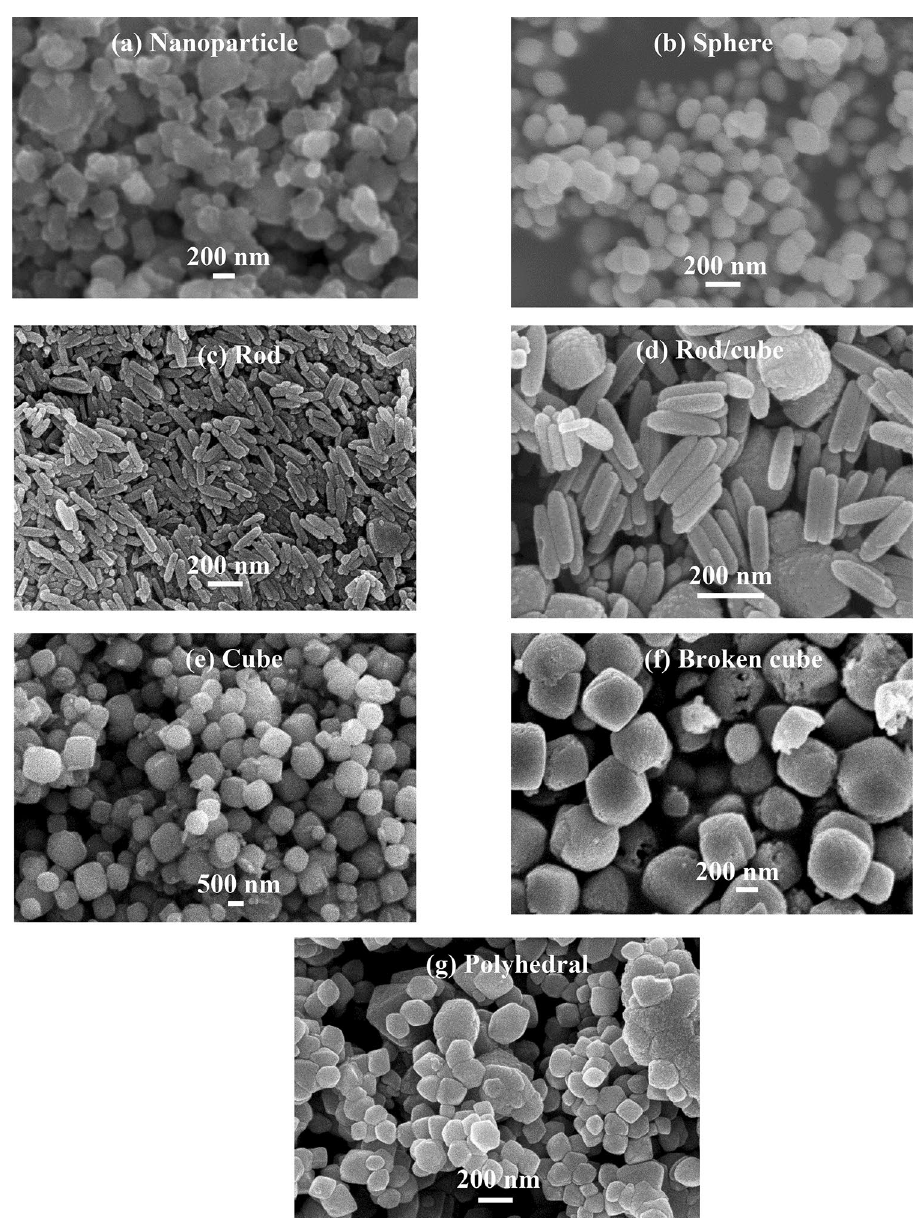
Figure 2. SEM images of the α-Fe 2 O 3 materials synthesized at various concentration ratios of FeCl 3 and CTAB: ( a ) C FeCl 3 / C CTAB = 0.02 / 0.0 (nanoparticle), ( b ) 0.02 / 0.01 (sphere), ( c ) 0.05 / 0.01 (rod), ( d ) 0.05 / 0.02 (rod/cube), ( e ) 0.05 / 0.04 (cube), ( f ) 0.07 / 0.04 (broken cube), ( g ) 0.03 / 0.04 (polyhedral).